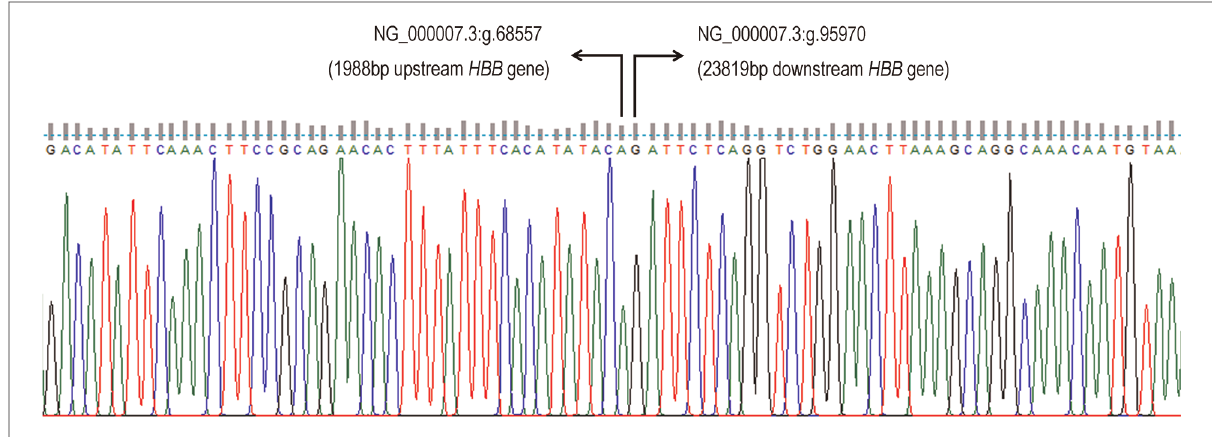
FIGURE 2 The β °-thal SEA ∼ 27 kb deletion can be mapped from the 1,987 bp upstream of HBB gene to 23,818 bp downstream of β -globin gene ( HBB gene) (NG_000007.3:g.68558_95969del). Number of nucleotide deleted was 27,412